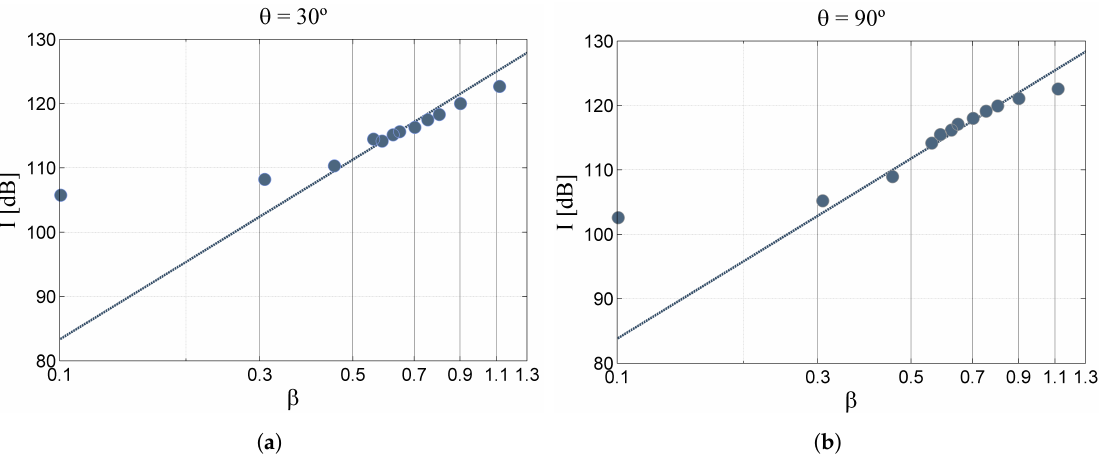
Figure 22. Variation of the sound intensity with the off-design parameter. The solid line indicates the β 4 trend. ( a ) Microphone located at θ = 30 ◦ ; ( b ) Microphone located at θ = 90 ◦